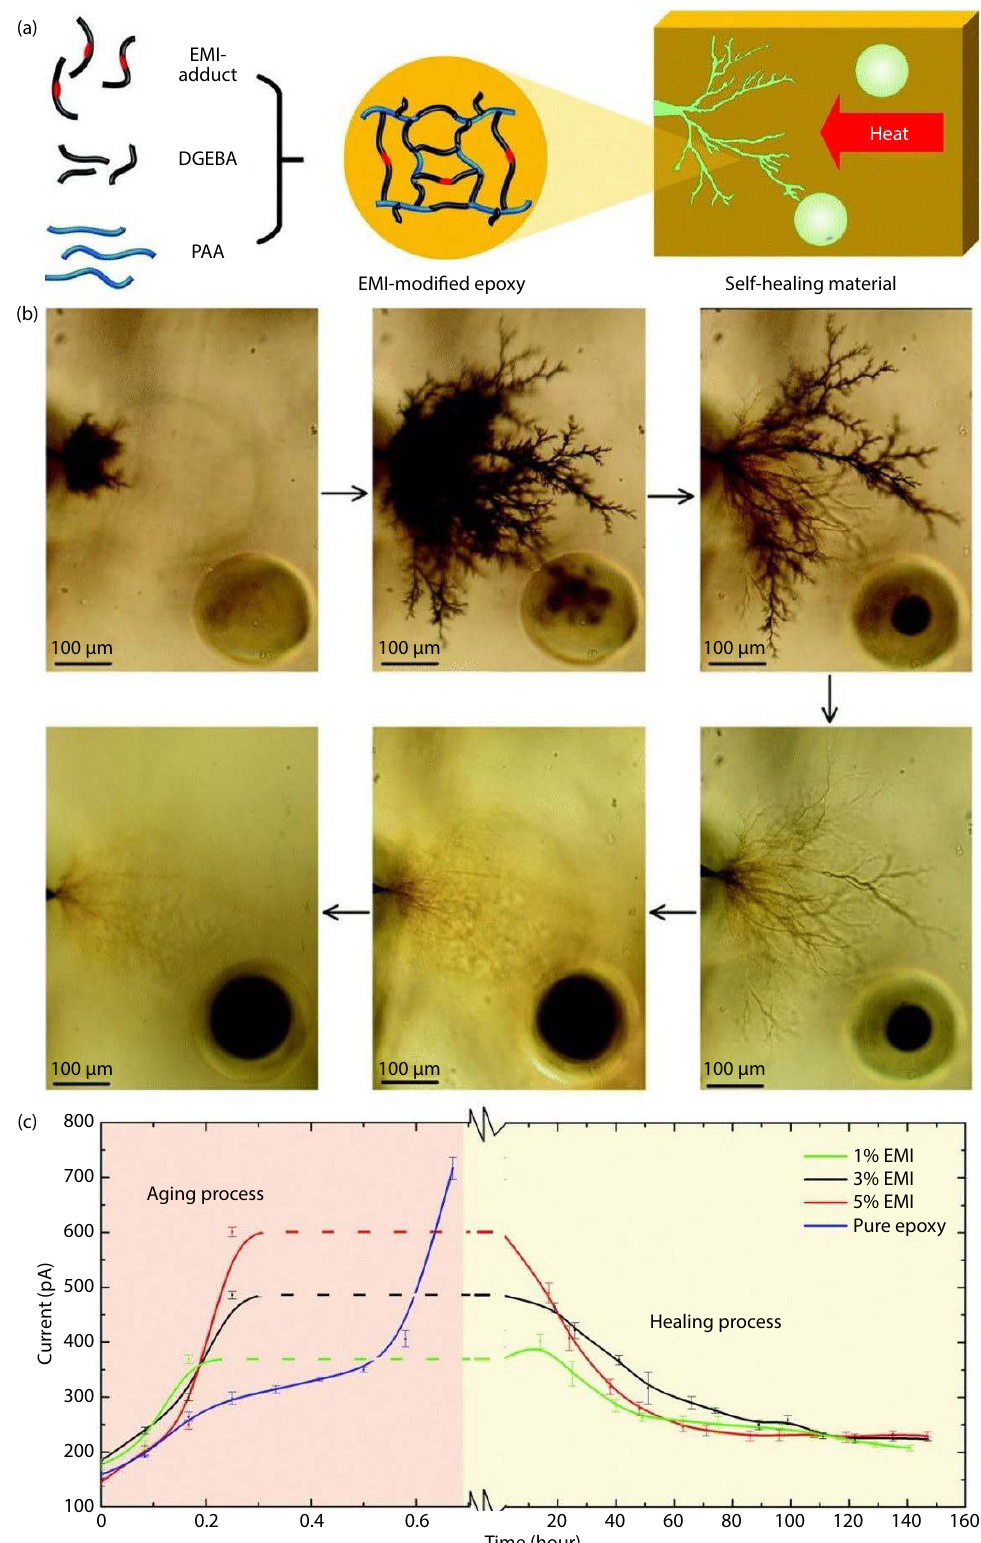
Fig. 19 Microcapsule-based self-healing insulating materials triggered by latent functionality. ( a ) Schematic of fabricating self-healing epoxy by latent functional- ity. Epoxy monomer DGEBA, primary curing agent PAA and latent hardener EMI were mixed to produce EMI-modified epoxy. Self-healing was obtained by cross- linking of EMI and epoxy monomers from microcapsules. ( b ) Optical microscope images of aging and healing process of self-healing epoxy samples. ( c ) Leakage cur- rent of epoxy specimens with different concentrations of EMI during electrical aging and healing. Reprinted with permission from ref. [239], © 2020 The Royal Soci- ety of